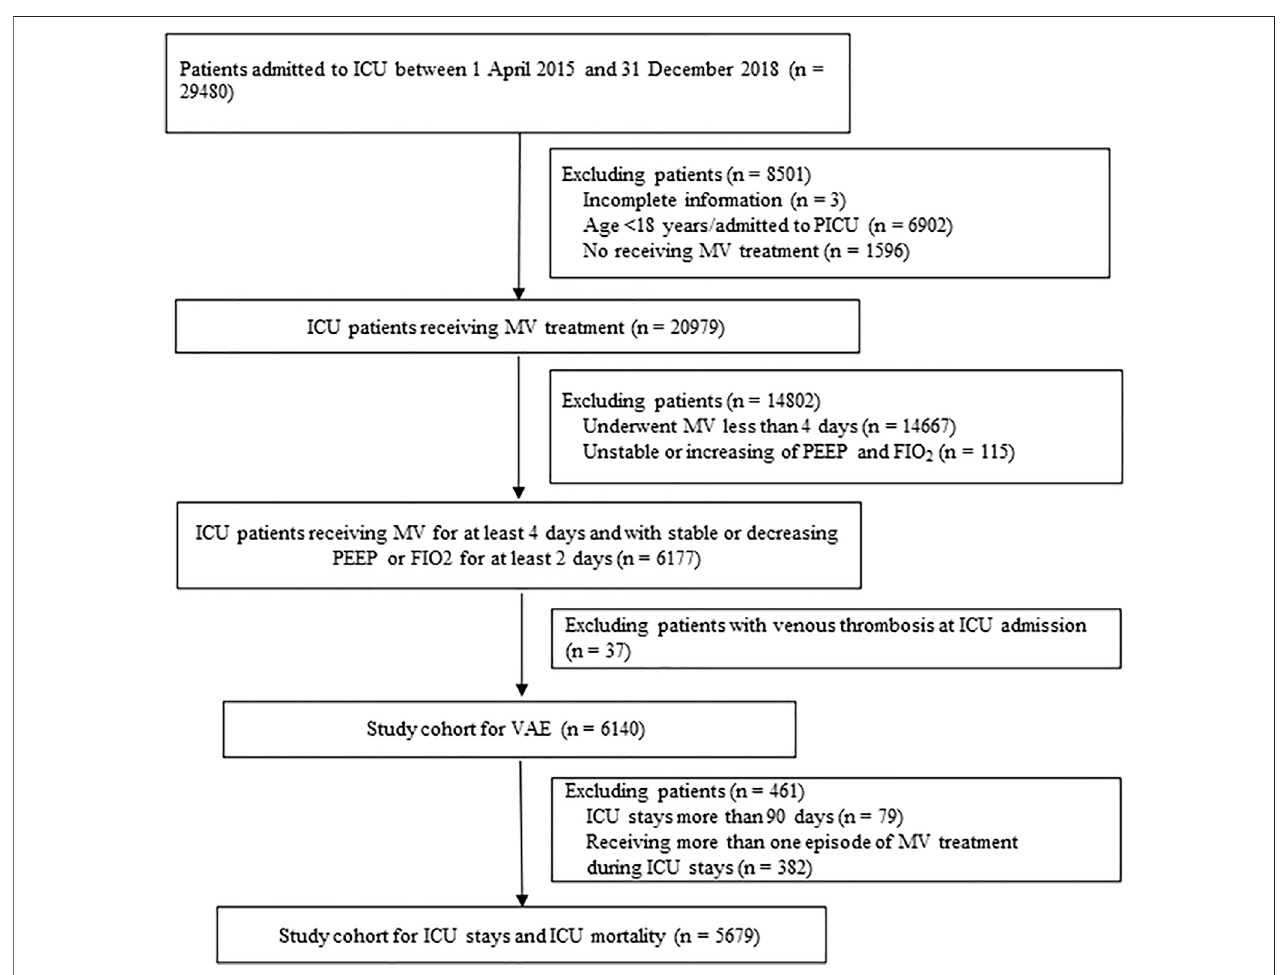
FIGURE1| Study fl owchart.ICU:intensivecareunits;MV:Mechanicalventilation;PEEP:Positiveend-expiratorypressure;FIO 2 :Fractionofinspiredoxygen;VAE: Ventilator-associated events